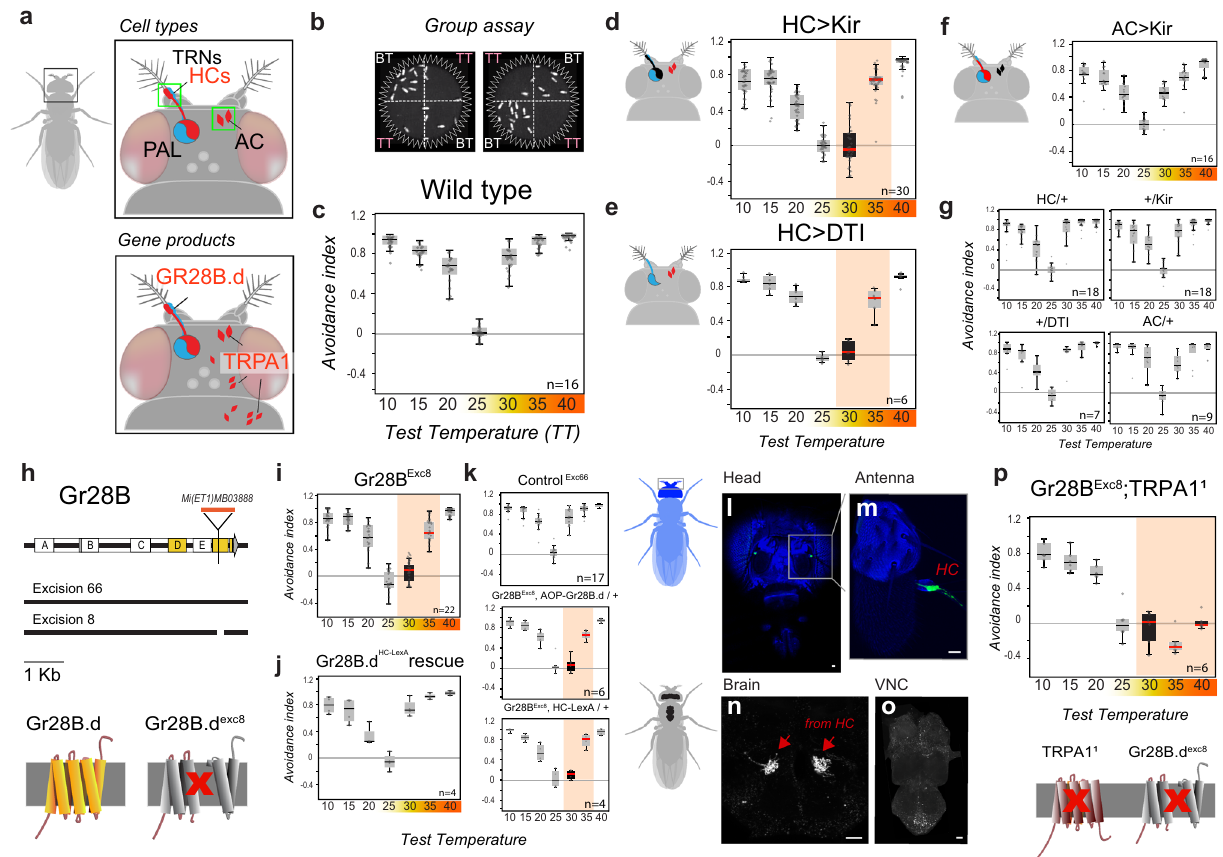
Fig. 1 Noxious and innocuous heat sensing together mediate heat avoidance in Drosophila . a Schematic representation of the cell types and gene products involved in heat sensing in adult Drosophila (TRNs: temperature receptor neurons, HCs: hot cells, AC: anterior cells, PAL: posterior antennal lobe). b , c Two-choice assay for temperature preference. b Groups of fl ies are given a choice between a base temperature (BT, 25 °C; n = no. of groups) and a variable test temperature (TT; a single video frame is shown). c Temperature preference is quanti fi ed as an avoidance index for the various test temperatures (wild type is shown). d Genetic silencing (by expression of Kir2.1, a hyperpolarizing agent) or ( e ) ablation (by Diphteria toxin, DTI, a cell killing toxin — under the control of HC-Gal4) of hot TRNs of the arista abolishes avoidance of 30 °C and reduces avoidance of 35 °C. f Genetic silencing of AC (in AC-Gal4>UAS-Kir2.1) has no effect on avoidance. g Control genotypes (drivers and effectors). h Creation of a GR28B null mutant. Schematics of the Gr28B genomic locus, Minos insertion, genomic excisions produced for this work and effect of excisions on the predicted protein. i An excision in one of the common exons (Exc8) abolishes avoidance of 30 °C and reduces avoidance of 35 °C. j Targeting expression of a GR28B.d cDNA to hot-activated TRNs (by HC-LexA) completely rescues avoidance defects. k Controls. l – o HC-LexA expression visualized by GFP (in HC-LexA>Aop-GFP animals). l , m Confocal stacks from head/antennae (blue = cuticle auto fl uorescence, green = GFP expression in Hot TRNs of the arista; scalebars = 20 μ m). n – o 2- photon stacks of brain and ventral nerve chord (VNC), showing ( n ) hot TRNs axon terminals in the brain, and ( o ) no labeling in the VNC (scalebars, 20 µ m). p Gr28B Exc8 , TRPA1 1 double mutants display no heat avoidance, but normal cold avoidance. In all boxplots, the edges of the boxes are the fi rst and third quartiles, a solid line marks the median, and whiskers delimit the data range; a solid red median line denotes a signi fi cant interaction between experimental and control animals (two-way ANOVA, P < 0.001), a black box denotes avoidance indexes not signi fi cantly different from zero (one sample t test, P < 0.05). See Supplementary Fig. 1 for additional controls. P HC-Kir30 = 3.78e − 12, P HC-Kir35 = 6.74e − 4; P HC-DTI30 = 1.73e − 7, P HC-DTI35 = 2.74e − 5; P = 1.39e − 11, P = 4.67e – 6; P = 8.12e – 18, P = 3.8e – 7; P = 5.06e – 9; P = 8.01e – 6; P = 9.59e − 8; HC,AC-Kir30 HC,AC-Kir35 Exc8-30 Exc8-35 Exc8AOP-30 Exc8AOP-35 Exc8lexA-30